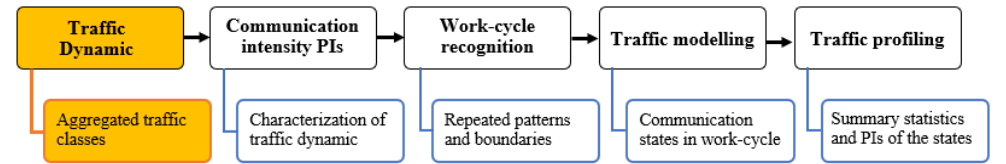
Figure 2. The proposed two-step approach overview; it builds on the network-level modeling method proposed in